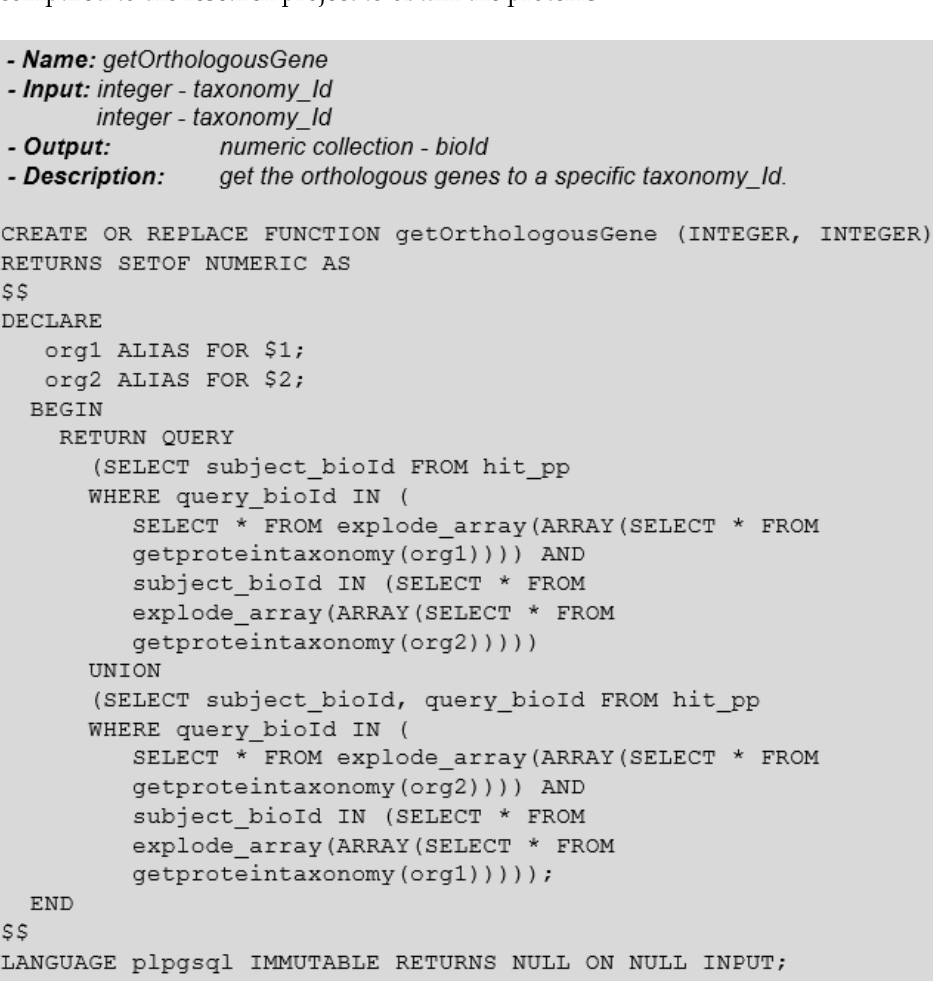
Figure 18. Function: